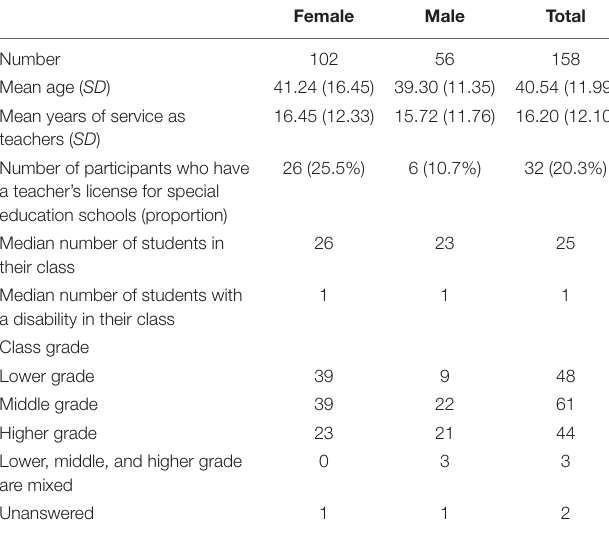
TABLE 1 | Demographic characteristics of the